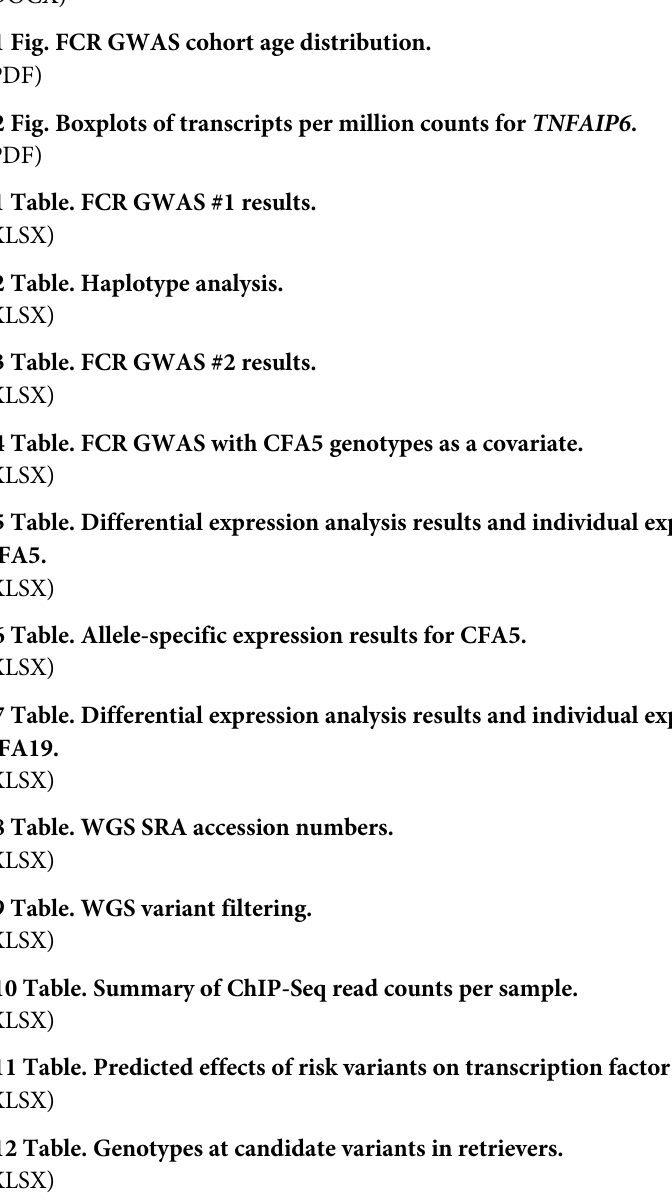
S10 Table. Summary of ChIP-Seq read counts per sample. S11 Table. Predicted effects of risk variants on transcription factor binding affinity. S12 Table. Genotypes at candidate variants in